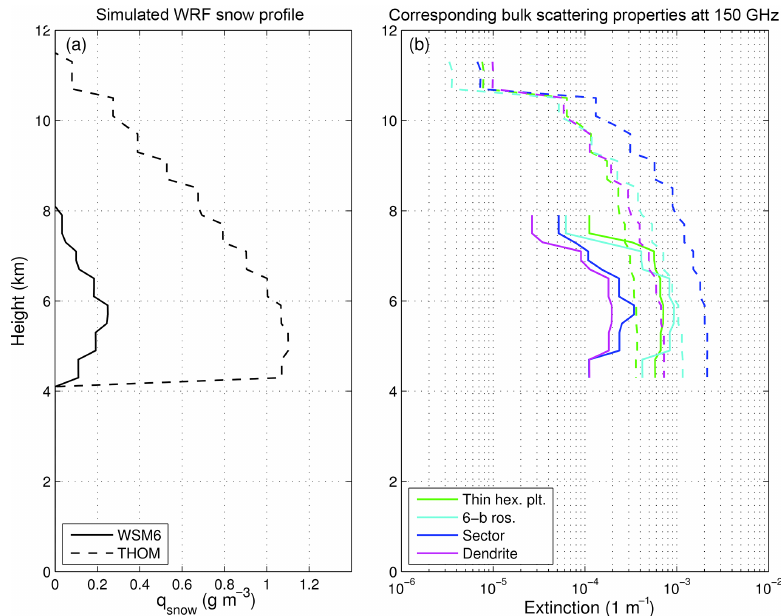
Figure 7. (a) The vertical profiles for the WSM6 and THOM snow mixing ratios (gm − 3 ) for the corresponding pixel of maximum snow water path in an MHS transect explored in Sect. 4 and introduced in Fig. 4i above. (b) The resultant vertical profile of the bulk scattering properties at 150GHz for the WSM6 (solid lines) and THOM (dashed lines) schemes, i.e. the extinction coefficient at each vertical level. The bulk optical properties have been computed at each vertical level by integrating the scattering properties of the equal mass Liu (2008) particle habits over the size distributions of